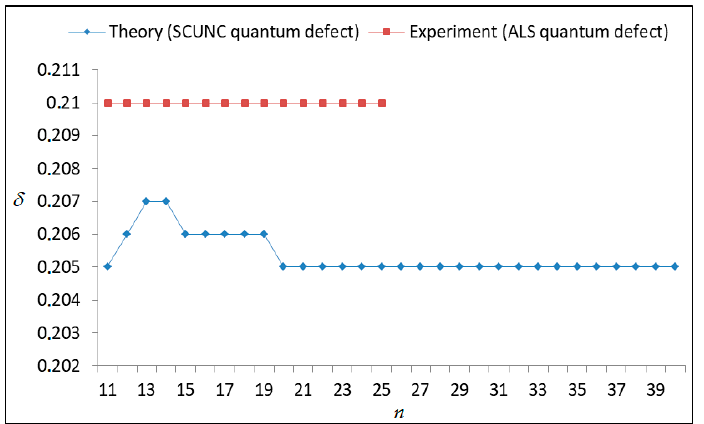
Figure 23. Variations of the quantum defect ( δ ) with the principal quantum number n for the 4 s 2 4 p 2 ( 3 P 2 ) nd Rydberg series originating from the 4 S ° 3/2 metastable state of Se + converging to the 3 P 2 series limits in Se 2+ .